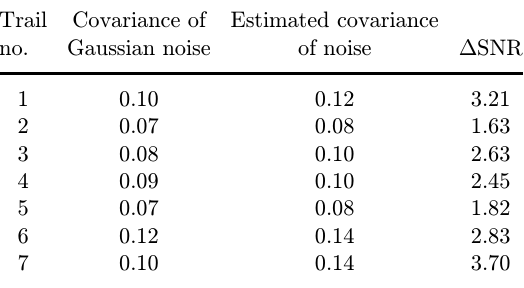
Table 1. Results of applying AR based method to simulated data. Trail